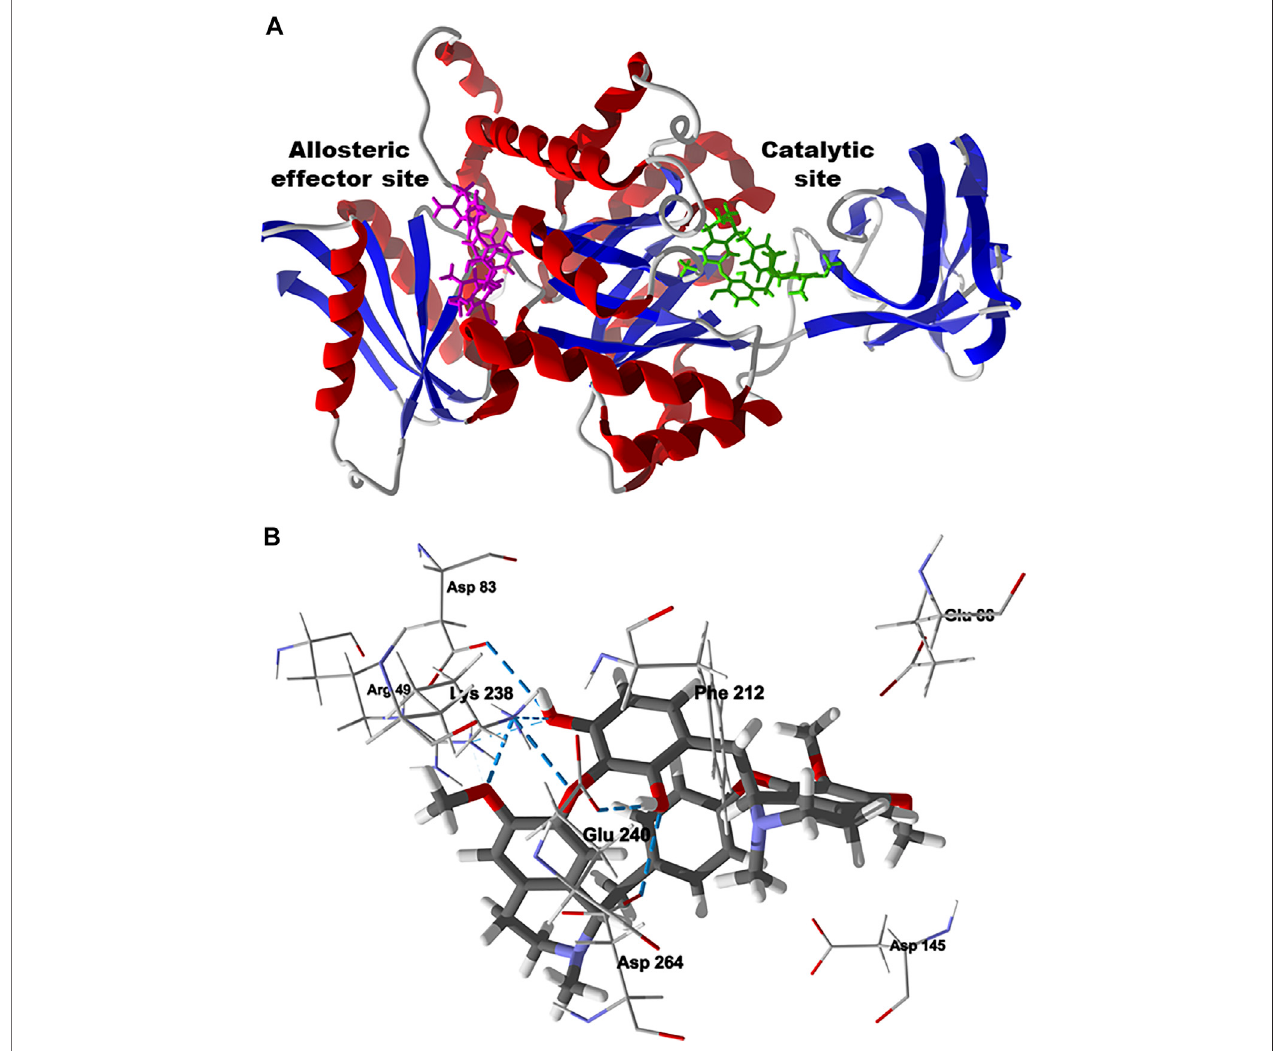
FIGURE 11 | Lowest-energy docked poses of chondrofolinol with Leishmania mexicana pyruvate kinase (Lmex PYK, PDB 1PKL). (A) : Ribbon structure showing the docked chondrofolinol poses in the allosteric effector site (magenta stick fi gure) and the catalytic site (green stick fi gure). (B) : Lowest-energy docked pose of chondrofolinol showing the key intermolecular contacts (hydrogen-bonded interactions are indicated with blue dashed lines).